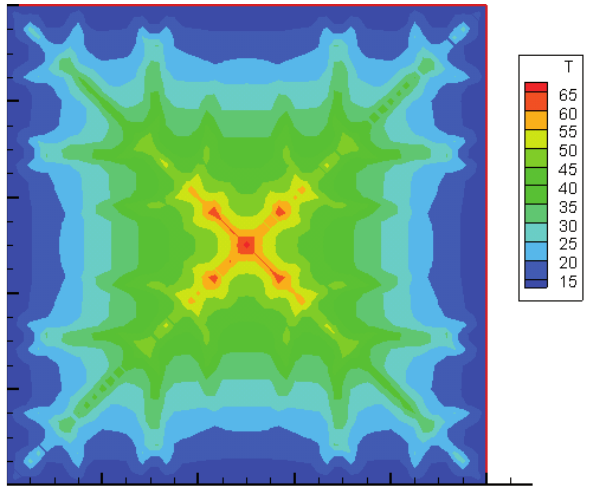
Fig. 6. Temperature distribution of optimal design based on SIMP